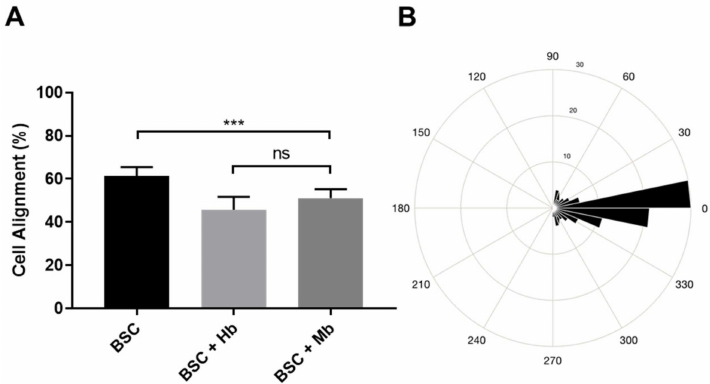
Figure 6. Alignment of BSCs. ( A ) BAMs generated from BSC, BSC + Hb, or BSC + Mb (3 mg / mL for both heme proteins) were stained with calcein AM and imaged with a fluorescent microscope, after which images were processed on Fiji with the Directionality tool (Fourier method). Cell alignment was determined as the percentage of structures that were aligned between − 10 ◦ and 10 ◦ in relation to the axis of alignment (0 ◦ ). Statistical significance was determined by one-way ANOVA and Tukey’s multiple comparison post hoc test ( α = 0.05). Error bars are standard deviations ( n = 9). ( B ) Average myotube orientation of the control group (BSC) was visualized by representative MatLab rose plot. *** p ≤ 0.001.